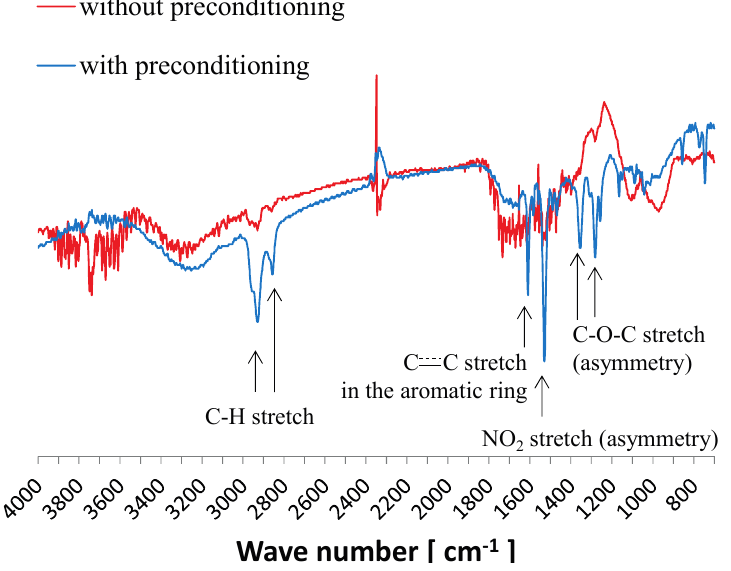
Figure 4. FTIR-RAS with transfer method for samples with and without the preconditioning for 7 days.